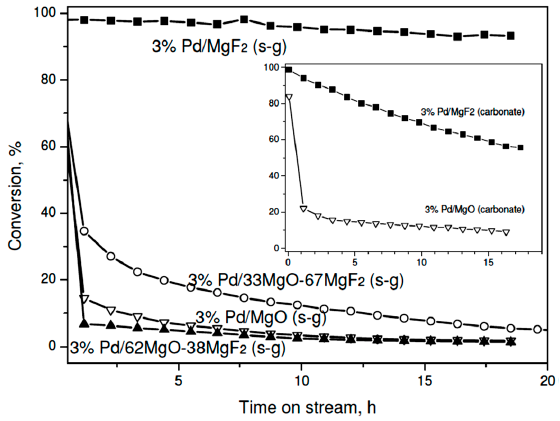
Figure 2. Time on stream behavior of 3 wt % Pd/MgO-MgF 2 (sol-gel) catalysts in CCl 4 hydrodechlorination at 90 °C. Inset: The behavior of the “carbonate” series of catalysts.